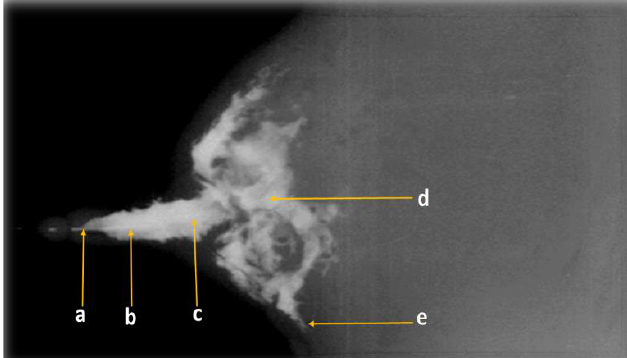
Figure 8. Radiographic image of the fore quarter in non-lactating udder (10 mL of barium sulfate contrast media) shows: (a)Teat orifice (b) Teat canal (c) Teat sinus (d) Lactiferous sinus (e) Lactiferous